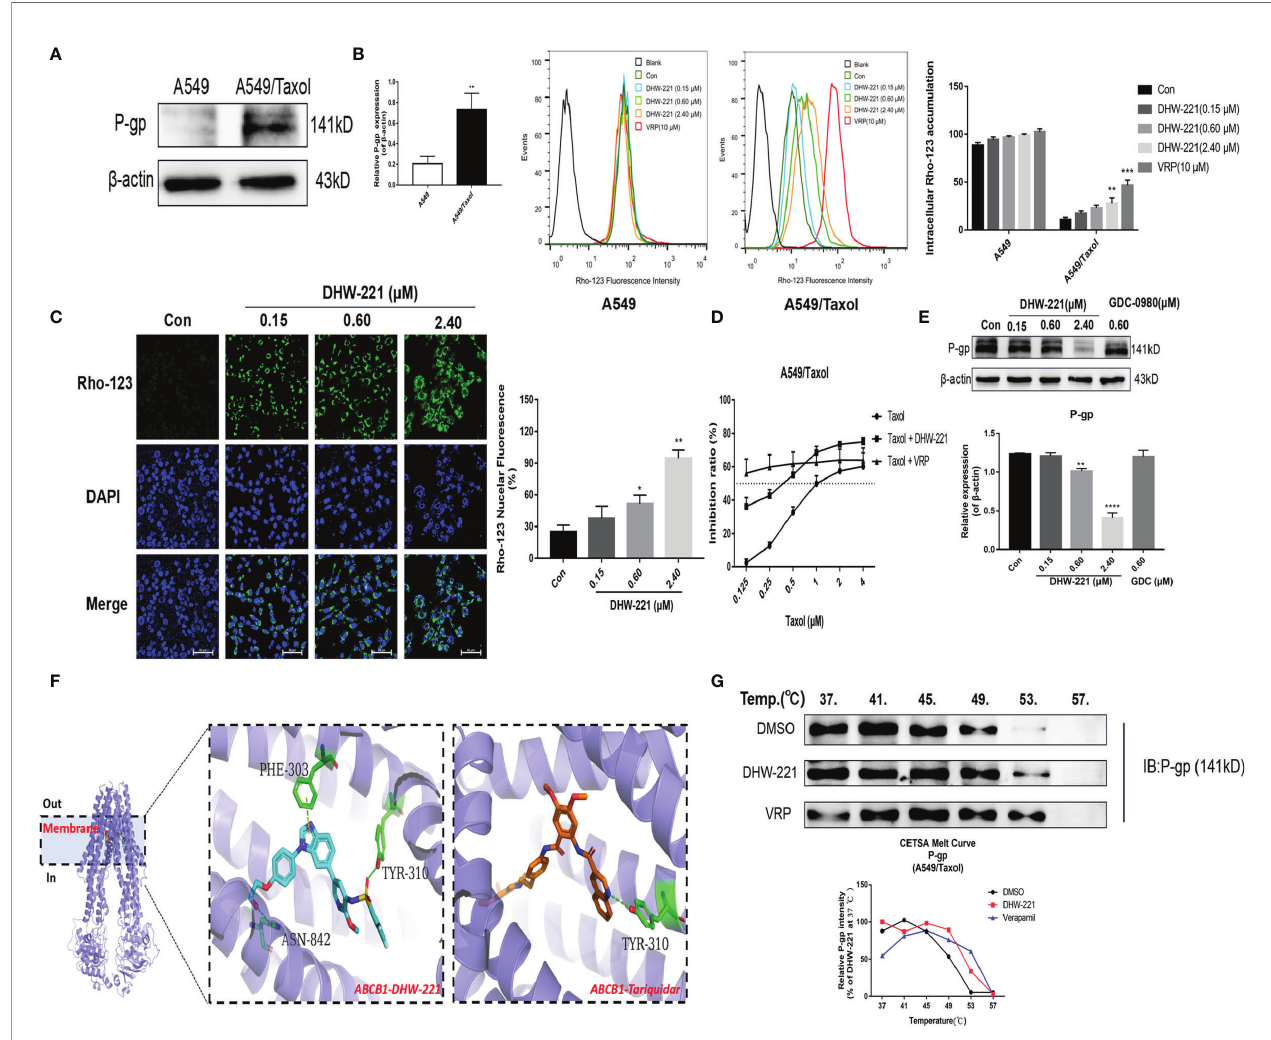
FIGURE 2 | DHW-221 accelerates intracellular Rho-123 accumulations and inhibits P-gp expression by binding to P-gp. (A) Comparison of P-gp in A549 and A549/Taxol cells. Statistical comparisons were performed with unpaired Student ’ s t-test (n = 3). **p < 0.01 versus A549. (B, C) After treatment of DHW-221 or verapamil for 48 h, Rho-123 (15 µM) was added into the mediums to co-incubate with DHW-221 or verapamil for 3 h in dark. The intracellular accumulation of Rho- 123 was evaluated by fl ow cytometry and confocal microscope, respectively. Verapamil (VRP, 10 m M) was used as a positive control. Green fl uorescence indicated Rho-123, and blue fl uorescence indicated DAPI. Scale bar = 100 m m. Nuclear mean fl uorescence intensity of Rho 123 was measured by ImageJ and analyzed using FlowJo 10 software. Statistical comparisons were performed with one-way ANOVA followed by Dunnett ’ s post-hoc test for multiple comparisons (n = 3). *p < 0.05, **p < 0.01, ***p < 0.001 versus control. (D) Effect of DHW-221 or verapamil to reverse Taxol resistance for 48 h in A549/Taxol cells. (E) Western blot analysis of DHW-221 inhibited P-gp expression in A549/Taxol cells. (F) Ribbon diagram of human ABCB1 (PDB code: 7A6E, purple spiral) bound to drug (membrane region) and predicted binding modes for DHW-221 (blue stick) and tariquidar (orange stick, a known third-generation P-gp inhibitor) with ABCB1. Hydrogen bonds were shown as green dashed lines. Key residues for DHW-221 and tariquidar interaction were highlighted. (G) Effect of DHW-221 on the thermal stability of ABCB1 was quantitatively detected by a cellular thermal shift assay (CETSA). Statistical comparisons were performed with one-way ANOVA followed by Dunnett ’ s post-hoc test for multiple comparisons (n = 3). Data are presented as mean ± SD. **p < 0.01, ****p < 0.0001versus